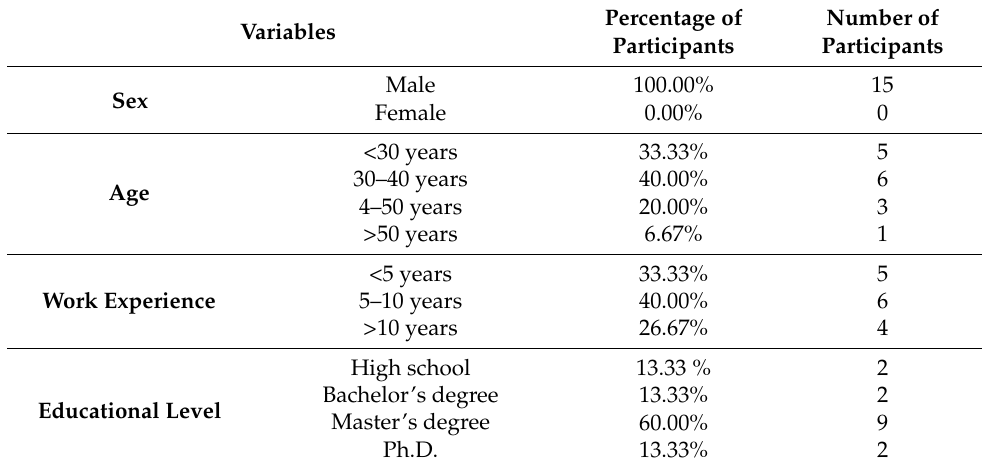
Table 3. Statistics and information about selected professionals based on criteria presented in Table 1.